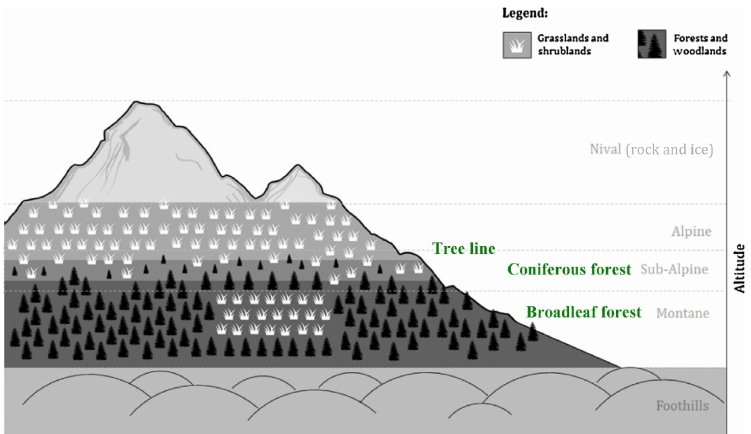
Figure B2. Diagram illustrating the delineation of montane, subalpine, alpine, and nival altitudinal belts relative to the location of shrubland and grassland ecosystems. Various shrub species are able to live in these altitudinal belts at the life form limit for shrubs, and could not be found in the nival belt. This figure was obtained from references (IPCC, 2001; Worboys and Good,